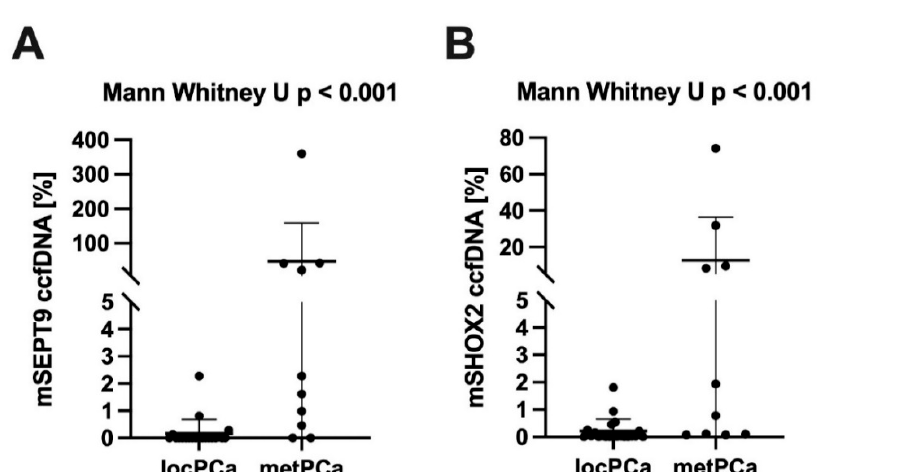
Figure 2. University Hospital Bonn Cohort: Quantitative methylated SEPT9 and SHOX2 in ccfDNA depending on tumor burden. ( A ) represents quantitative differences of mSEPT9 (methylated Septin 9 ) and ( B ) of mSHOX2 (methylated short stature homeobox 2 ) in ccfDNA (circulating cell-free DNA) between patients with locPCa (localized prostate cancer) and metPCa (metastatic prostate